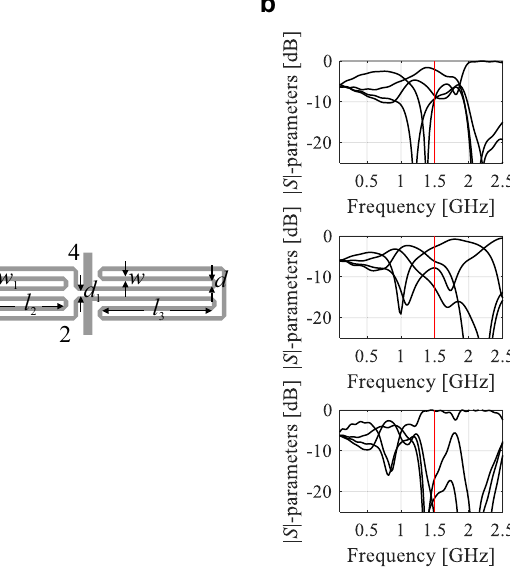
Figure 1. Miniaturized microstrip coupler and its scattering parameters versus frequency: ( a ) coupler geometry, ( b ) S-parameters at selected random designs within the assumed parameter space. The vertical lines mark the target operating frequency (here, 1.6 GHz). Local search carried out using the objective function such as (2) would fail when starting from most of the shown designs, due to severe misalignment between the target and the actual operating